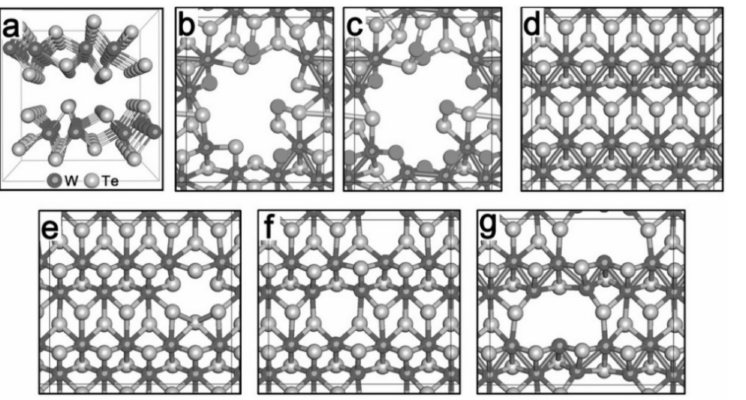
Figure 7. Atomic structures of ( a ) bulk WTe 2 , ( b ) 1 L W 8 Te 18 O 5 (W:Te = 1:2.25), ( c ) 1 L W 8 Te 14 O 9 (W:Te = 1:1.75), ( d ) 1 L W 16 Te 32 (W:Te = 1:2), ( e ) 1 L W 15 Te 32 (W:Te = 1:2.13), ( f ) 1 L W 16 Te 30 (W:Te = 1:1.875) and ( g ) 1 L W 16 Te 26 (W:Te = 1:1.625). Tungsten, tellurium and oxygen are shown